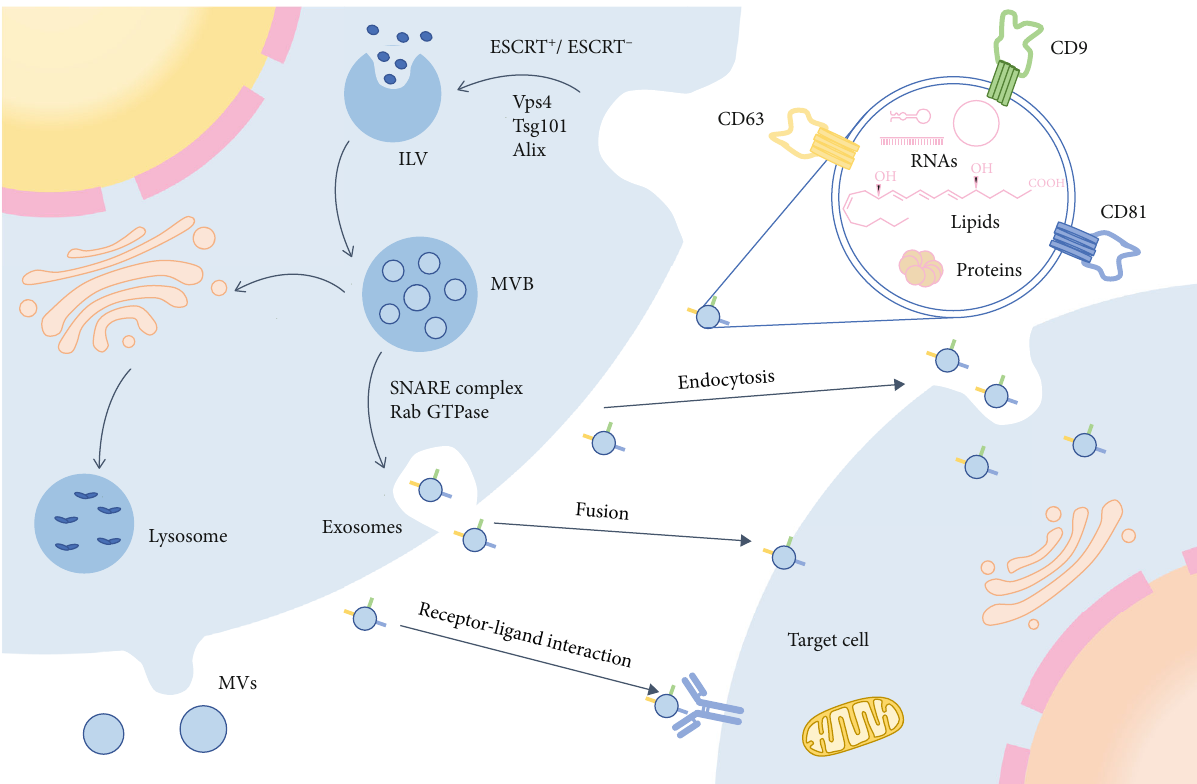
Figure 1: Biogenesis and cellular uptake of exosomes. The plasma membrane invaginates through the ESCRT-dependent and ESCRT- independent pathways to form ILVs. Late endosomes containing ILVs are called multivesicular bodies (MVBs). Some MVBs are transported to the Golgi complex circulation and fi nally transported to the lysosome for degradation, and some MVBs are fused with the plasma membrane under the in fl uence of the Rab family, SNARE complex, and tubulin before being released from the cell. Exosomes released from cells can enter target cells through fusion, receptor-mediated endocytosis, macrophage phagocytosis, or phagocytosis. The surfaces of exosomes contain many molecules. This fi gure shows three common molecules (CD9, CD63, and CD81) on the surface of